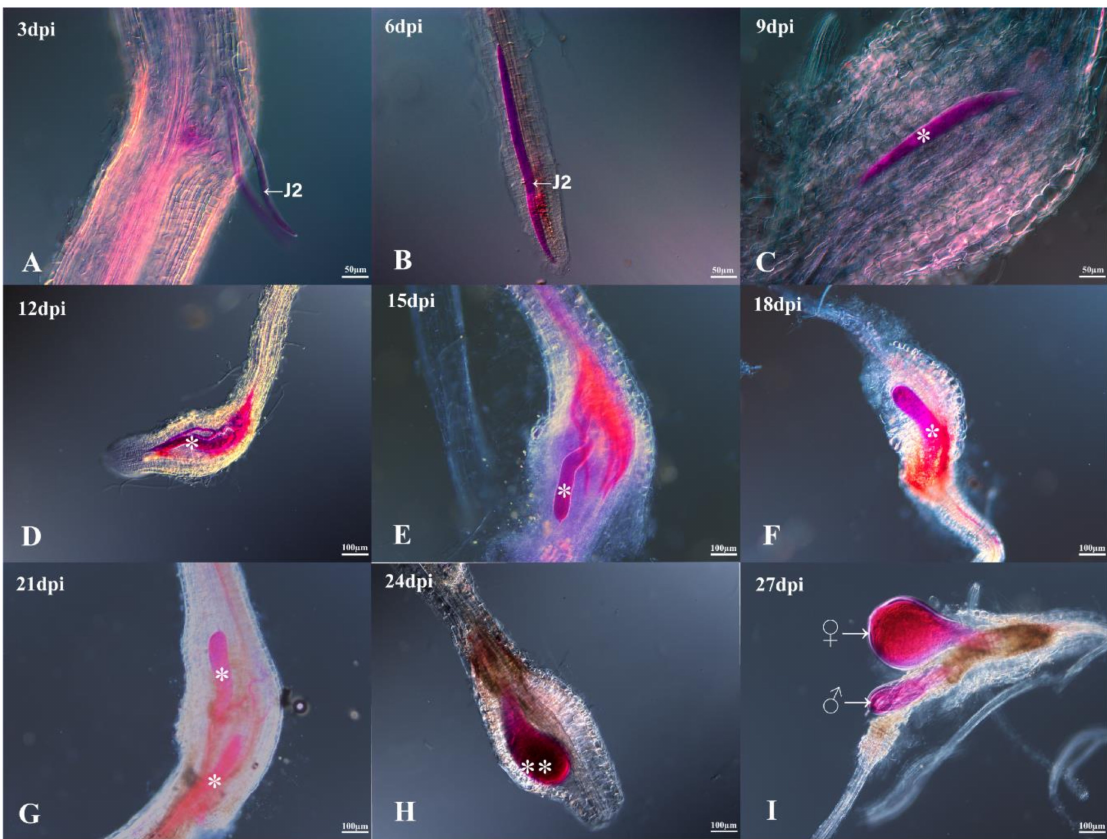
Figure 1. Meloidogyne incognita stained with acid fuchsin after infection of Nipponbare rice roots at 3 ( A ), 6 ( B ), 9 ( C ), 12 ( D ), 15 ( E ), 18 ( F ), 21 ( G ), 24 ( H ), and 27 ( I ) days post inoculation (dpi). J2: second-stage infective juveniles; one asterisk: sausage-shaped J2; two asterisks: globose root-knot nematode